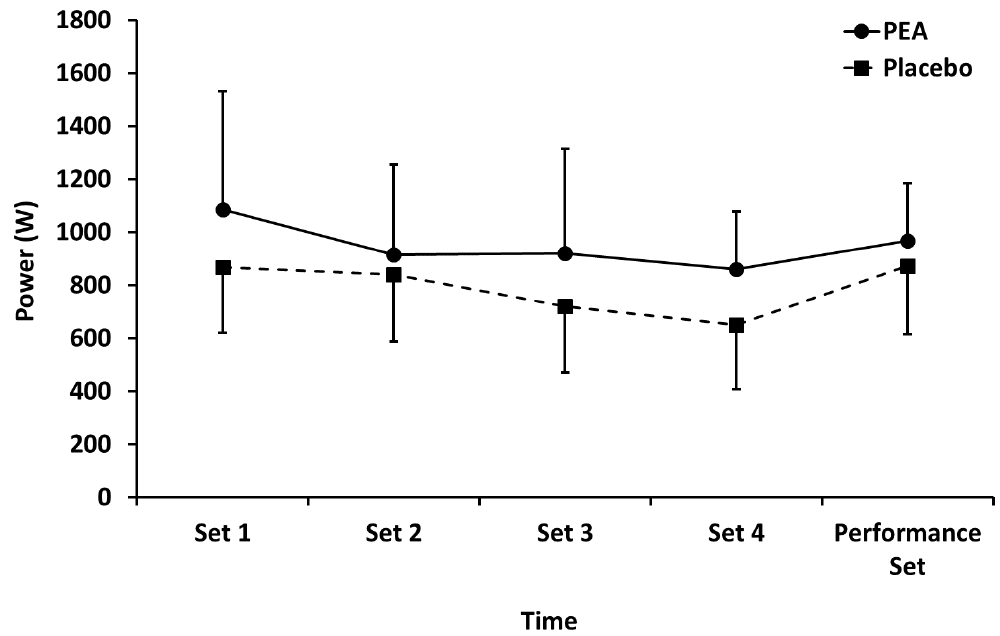
Figure 2. Mean power output during leg press exercise for palmitoylethanolamide (PEA) and placebo groups. Values are mean ± SD.